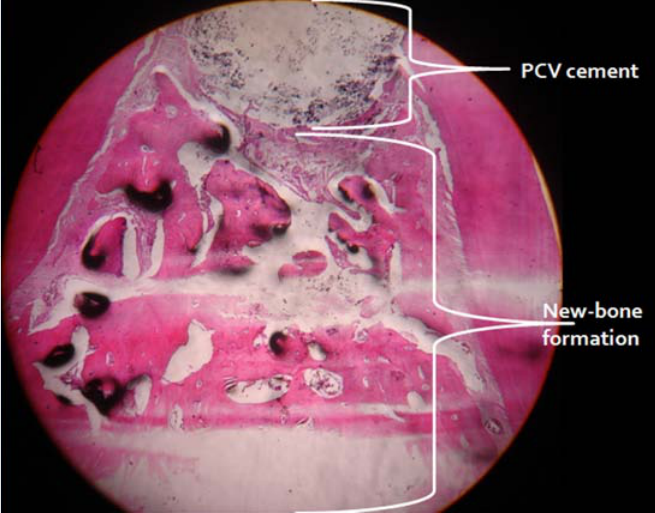
FIGURE 1 – Furcation treated with type V Portland cement. New-bone